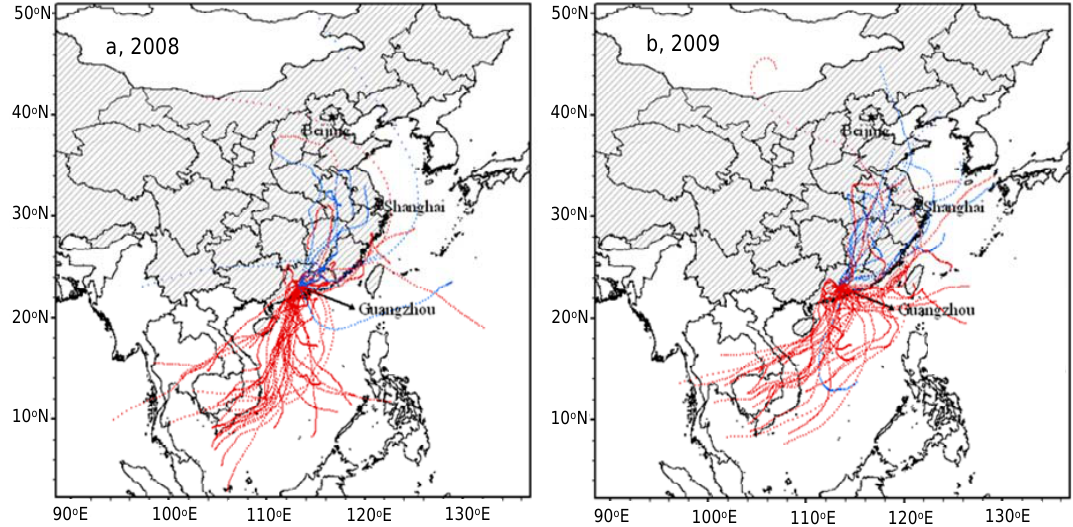
The P values were obtained by one-way ANOVA performed for each study year. Range (minimum and maximum) and one standard error of mean are given in parentheses.